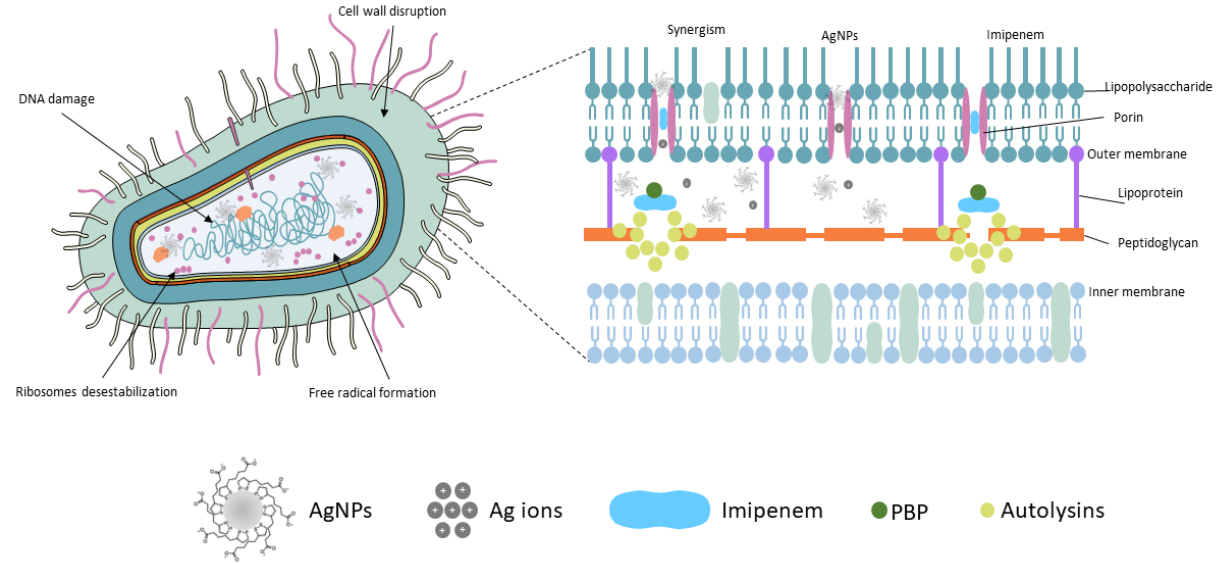
Figure 3. Schematic representation describing the interaction and antimicrobial action of silver nanoparticles, Imipenem, and the agents’ association on the Gram-negative bacterium.